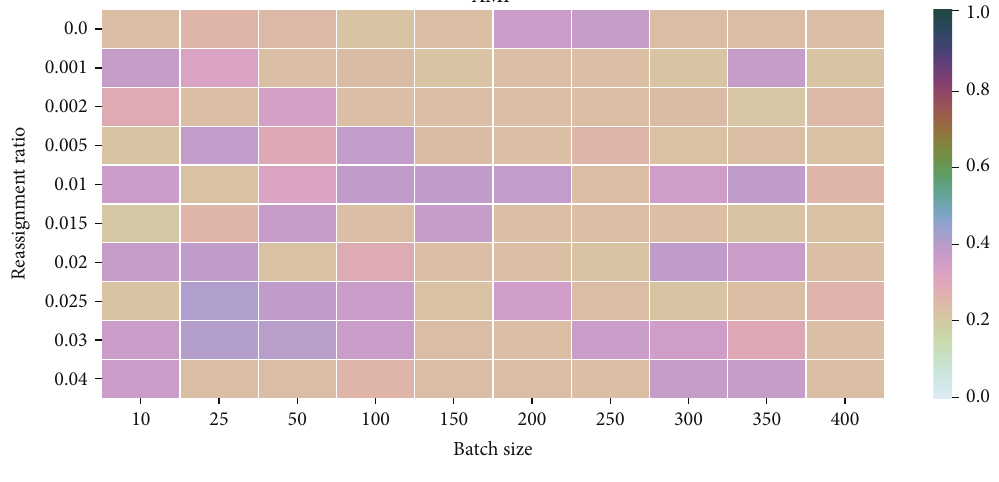
Figure 5: Heatmap of AMI scores.